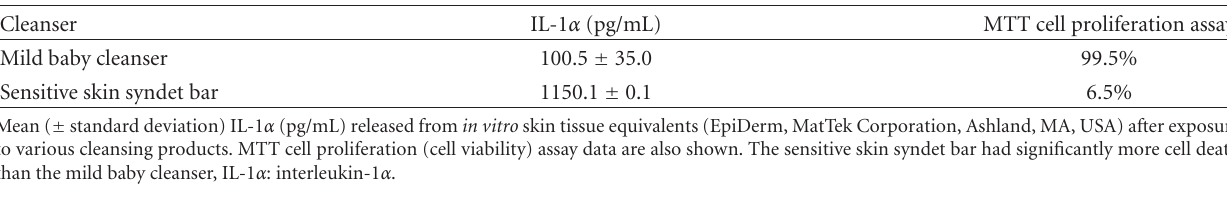
Table 3: Proinflammatory activity of commercially available cleansing